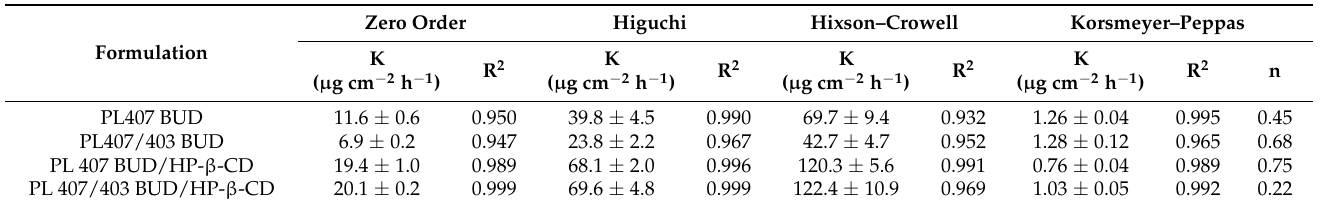
Formulation PL407